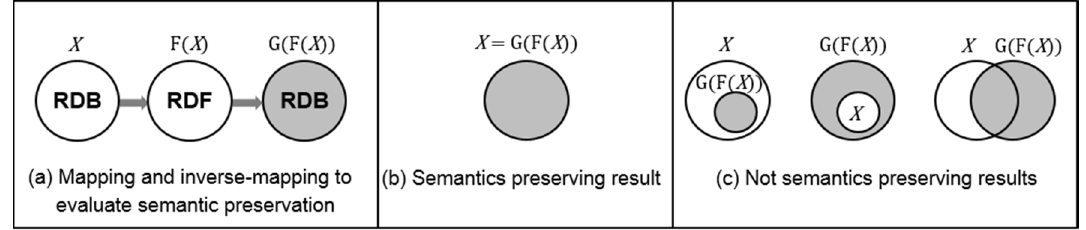
Figure 6. Graphical view of semantics preservation of direct mapping.